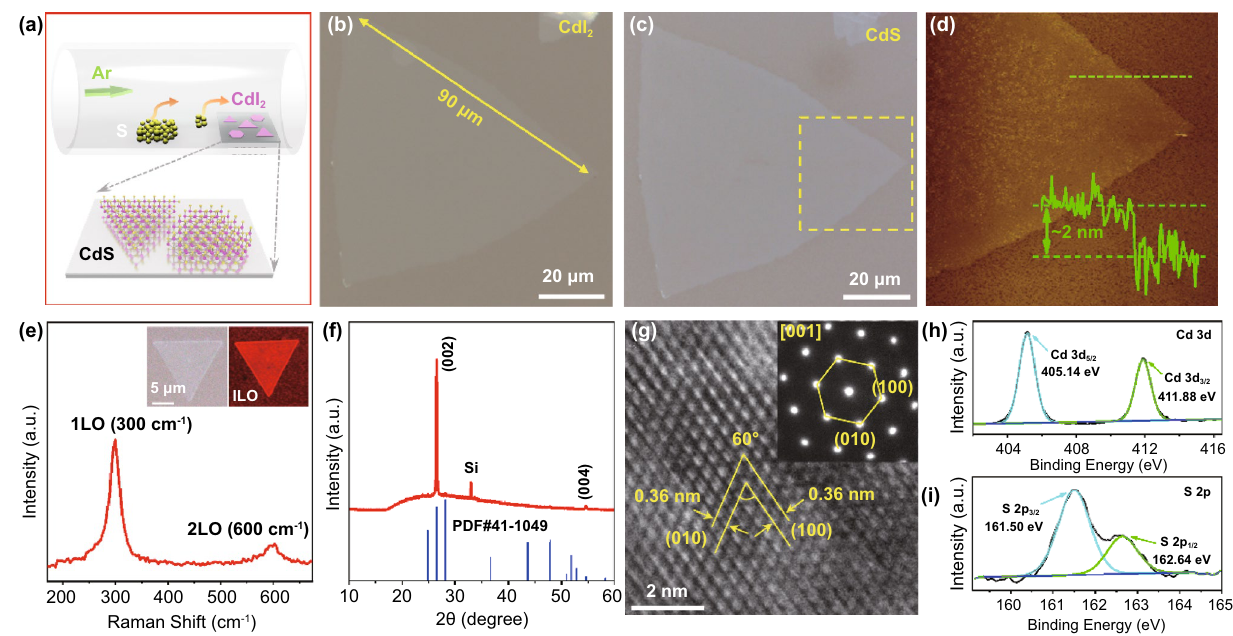
Fig. 3 Growth and characterization of nonlayered CdS flakes. a Schematic presentation of conversion setup and atomic structure of CdS flakes on mica substrate by chemical sulfurization method. b , c Representative OM images of original large-scale CdI 2 thin flake and converted CdS thin flake on mica substrates, respectively. d AFM image and corresponding height profile of thin CdS flake in panel c. e Raman spectrum of converted CdS flakes. The inset is the typical OM and Raman intensity mapping (1LO mode) of the triangular CdS flake. f XRD pattern of con- verted CdS flakes on SiO 2 /Si substrate. g HRTEM image of converted CdS flakes. The inset is the SAED pattern taken along the direction [001] of CdS flakes. h , i XPS spectra of Cd 3d and S 2p peaks from converted CdS